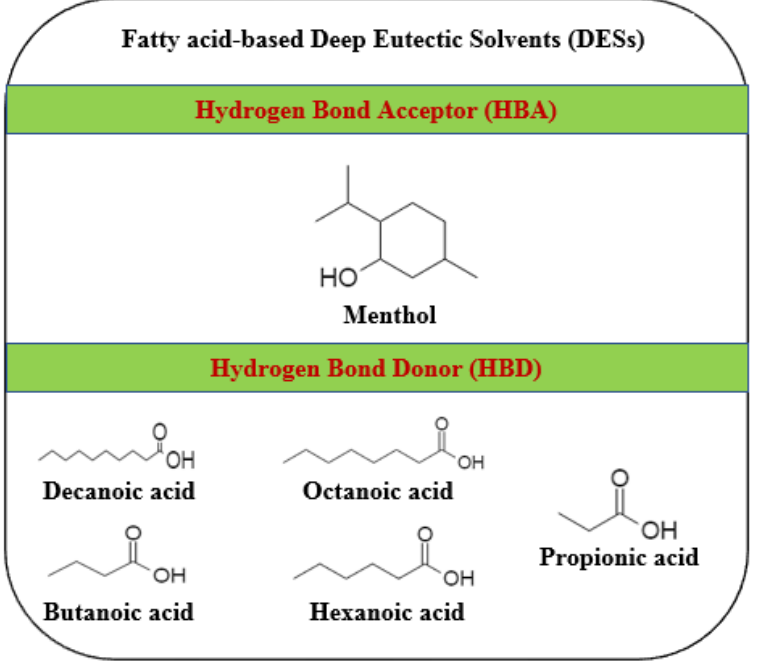
Figure 1. Chemical compositions of different fatty acids (decanoic acid, butanoic acid, octanoic acid, hexanoic acid, and propionic acid) as the hydrogen bond donors required to synthesize hydrophobic deep eutectic solvents (DESs) with menthol (hydrogen bond acceptor).